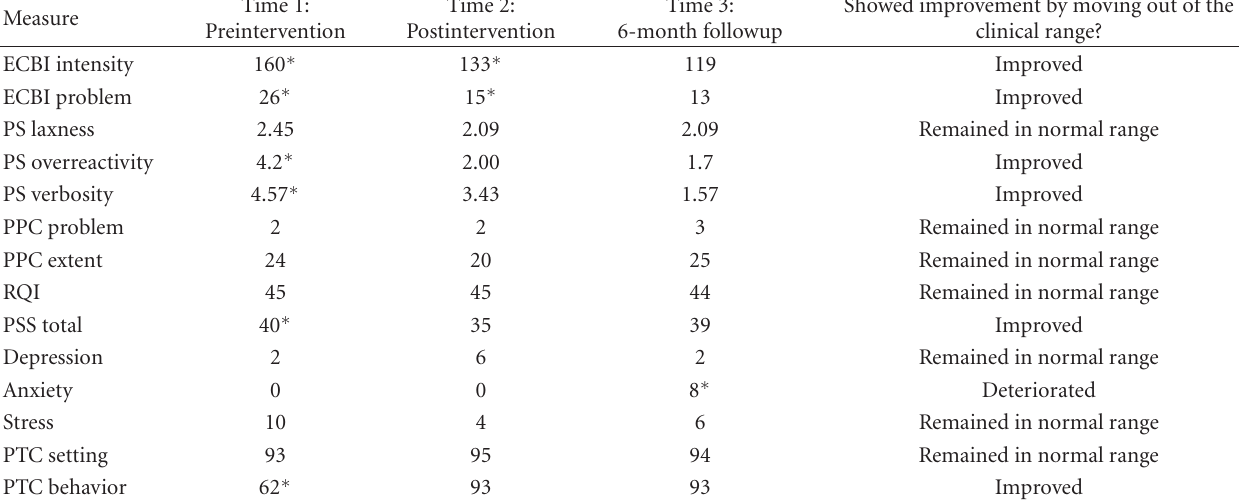
Table 1: Scores on each of the measures at three time points and indication of whether scores showed improvement by moving out of the clinical range.